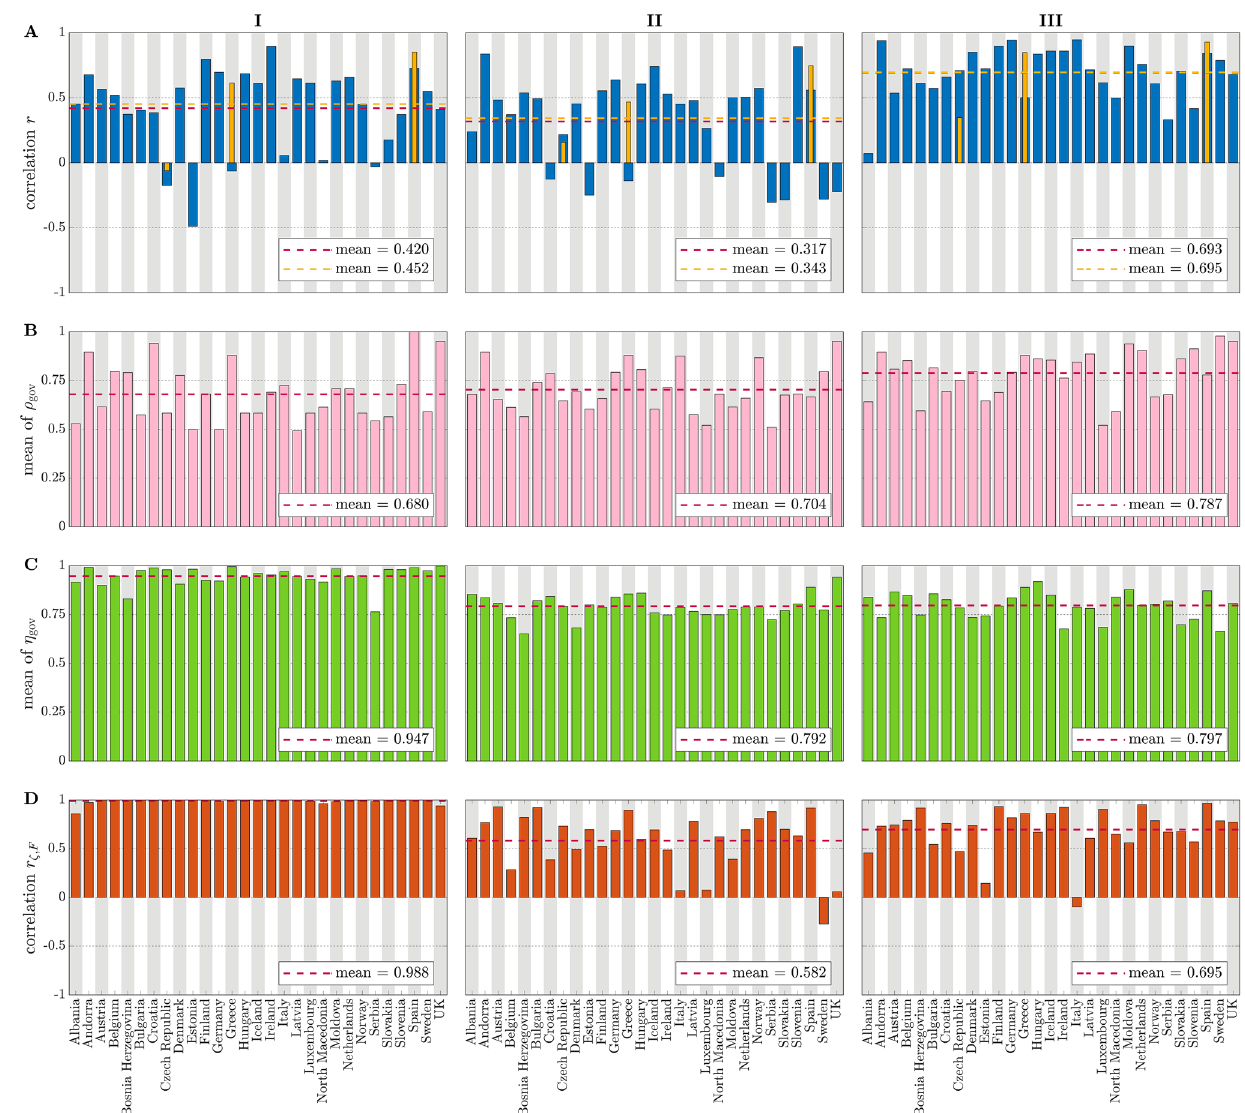
Figure 2. ( A ) Correlation between frustration and duration of the government negotiation talks, quantified in number of days from the general election to the date the government is sworn in or to the date the government negotiations fail, for each country and scenarios I , II and III . Blue bars consider only the cases of success, yellow bars consider both successes and failures. ( B ) Index ρ gov (overlap between party coalition entering in the government and party majority in the ground state); ( C ) index η gov (energy gap between ground state and “government state”). ( D ) Correlation between frustration and fractionalization index ( r ζ , F ), for each country and scenarios I , II and III . The average values (of correlation, in ( A , D ), or of the indexes, in ( B , C )) are reported inside each